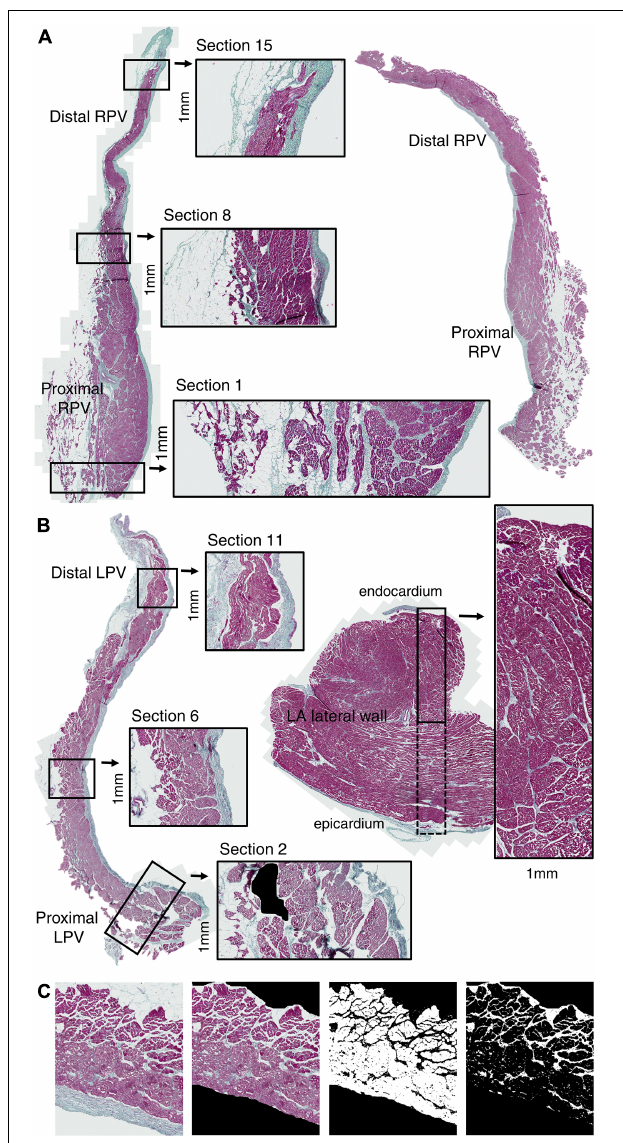
FIGURE 2 | Pulmonary vein histology. Slice along the longitudinal PV axis (proximal-distal) of RPV (A) and LPV (B) stained with Masson’s trichrome coloration (red: myocytes; green: collagen; black: nuclei). Sections (1 mm width) were positioned along the PV axis from proximal to distal. One transmural (endocardium-epicardium) section (1 mm width) was positioned in each LA lateral wall specimen (B) . Quantification of myocyte and collagen-fat tissue was performed in the PV tunica media excluding the endothelium and adventitia (C) . Artifacts, vessels, and perivascular collagen were also excluded from the analysis. Note the accumulation of collagen and fat tissue in the proximal PV.